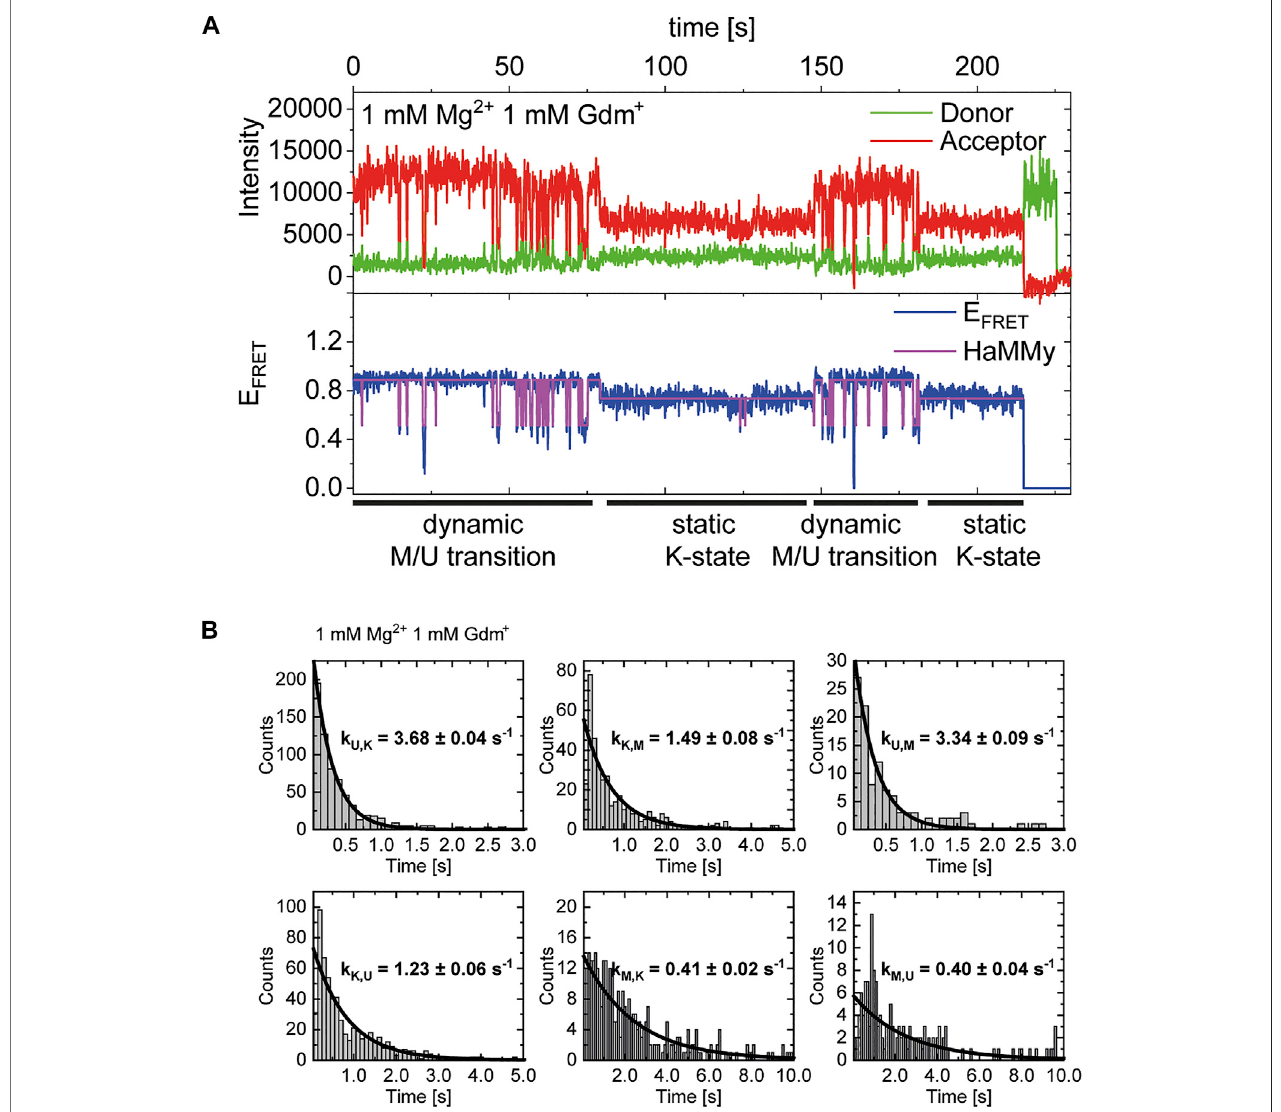
FIGURE 7 | (A) Example of time-resolved FRET behavior of an interconverting molecule switching between a dynamic M-state and a static K-state at constant 1 mM Mg 2+ and 1 mM Gdm + . (B) Examples of dwell time plots of 1 mM Mg 2+ and ligand each, used for transition rate calculations.